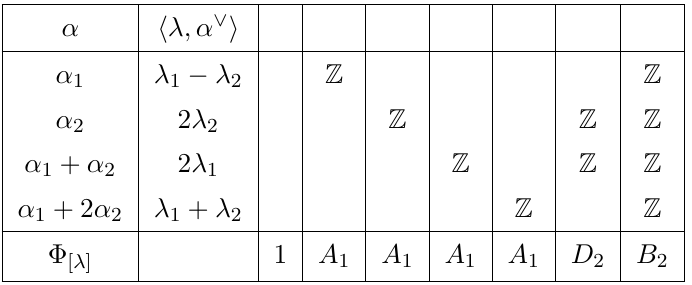
they give rise to. [ (cid:21) ]